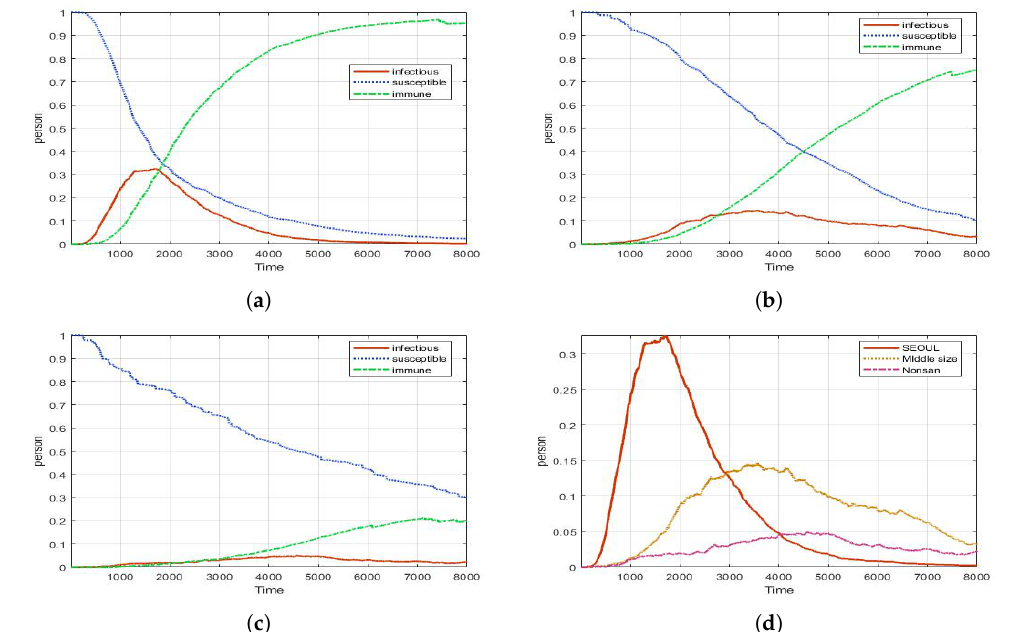
Figure 8. Experimental results for Screening (with different density of population): ( a ) Seoul (peak: 0.32, 1697 ticks); ( b ) Metro city (peak: 0.14, 3557 ticks); ( c ) Country (peak: 0.04, 4554 ticks); ( d ) Infec- tious for all